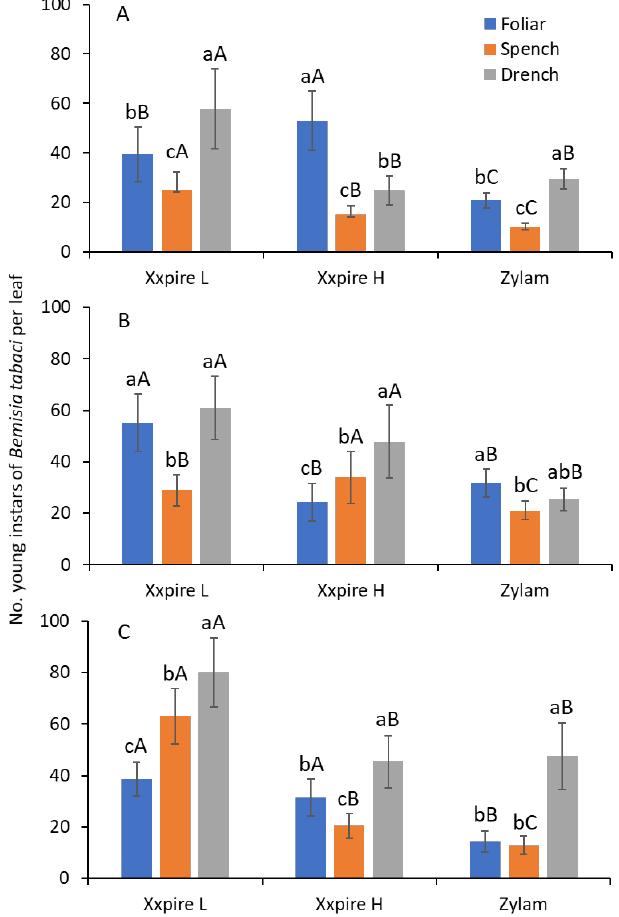
Figure 1. Young instars. Least-squares mean ( ± SE) number of young instars of B. tabaci observed on poinsettia leaves treated with various insecticides and application methods in the greenhouse at ( A ) 14, ( B ) 21, and ( C ) 28 days after application. Same lower-case letters among methods within insecticide treatment are not significantly different at α = 0.05 (Tukey–Kramer test), and same upper-case letters among same-colored bars (application method) are not significantly different at α = 0.05 (Tukey–Kramer